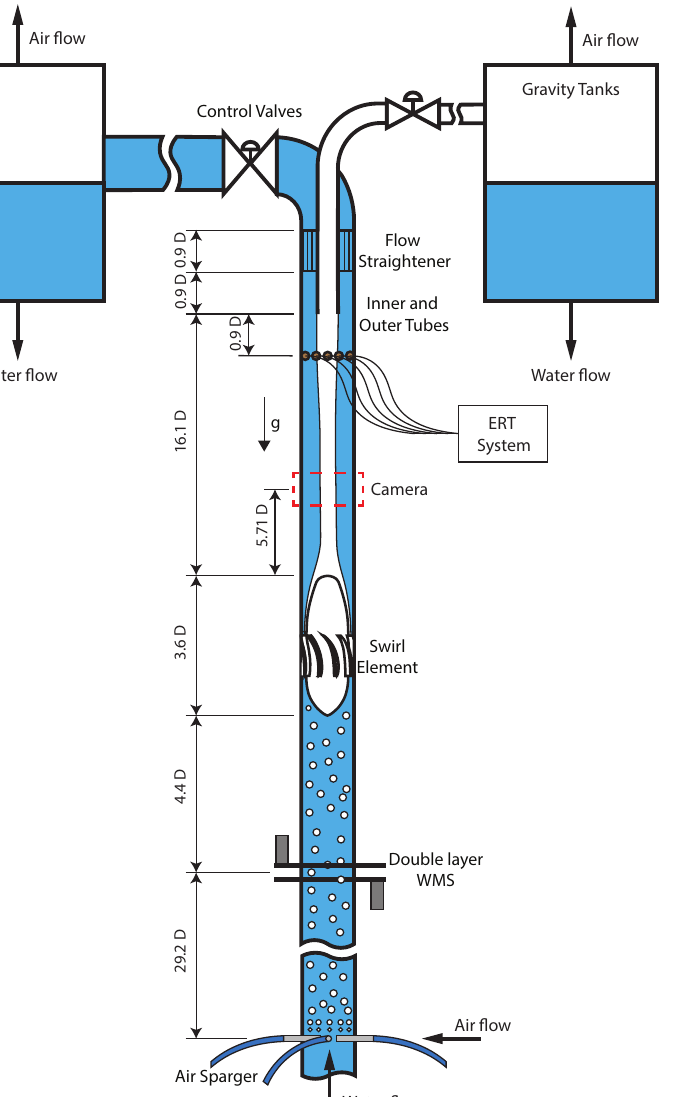
Figure 7. Main section of the Inline Swirl Separator of the Delft University of Technology. The separator has an inner diameter D = 81.4